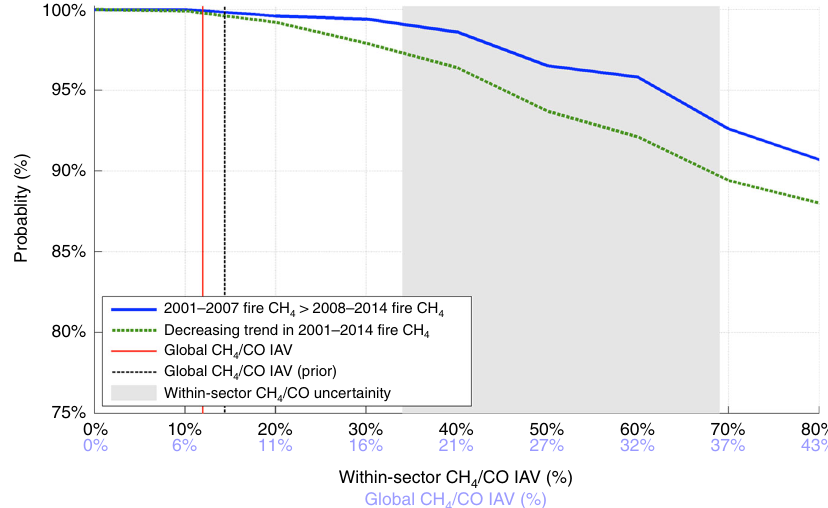
Fig. 2 The probability of a decrease in biomass burning methane emissions during 2001 – 2014. Probability of decrease if the emission factors are within- sector CH 4 /CO inter-annual variability (black, x axis) and the corresponding global-scale CH 4 /CO inter-annual variability (light blue, x axis). The probability estimates include the propagation of systematic errors in fi re CO emission estimates, and sector-speci fi c CH 4 /CO values. For comparison, the vertical lines show the global CH 4 /CO IAV due to annual changes in relative fi re sector contributions. The gray-shaded area shows the within-sector CH 4 / CO uncertainty